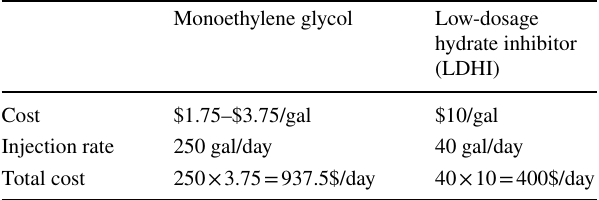
Table 5 Economic